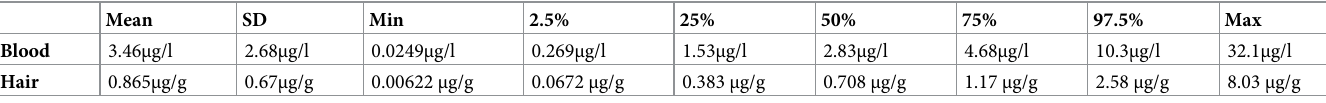
Table 1. Calculated maternal hair and blood concentration of methylmercury.